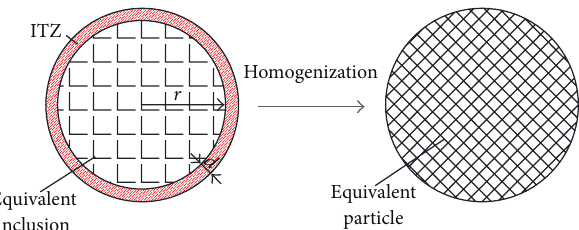
Figure 3: The equivalent particle attained by the second-level micromechanical homogenization to the two-phase composite made up of the ITZ and equivalent